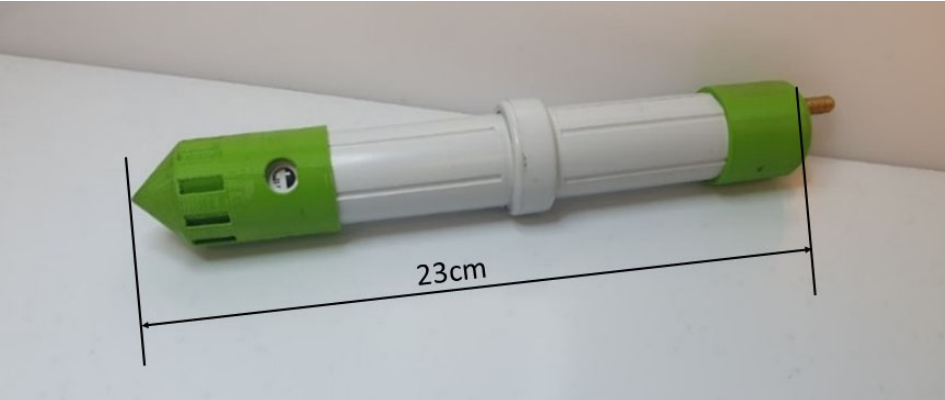
Figure 3. Probe casing with end caps designed for soil submersion.